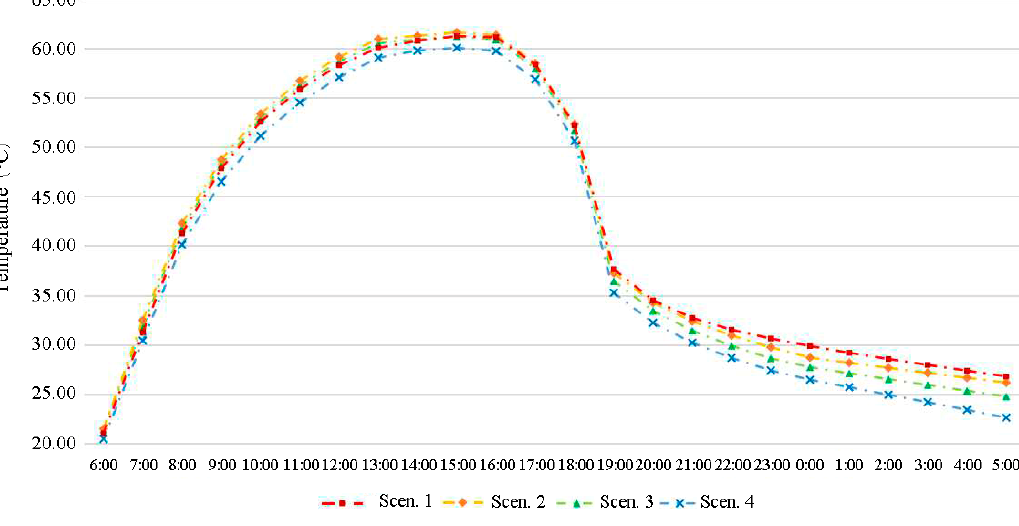
Figure 10. The outside wall surface temperature of the four scenarios in the day.